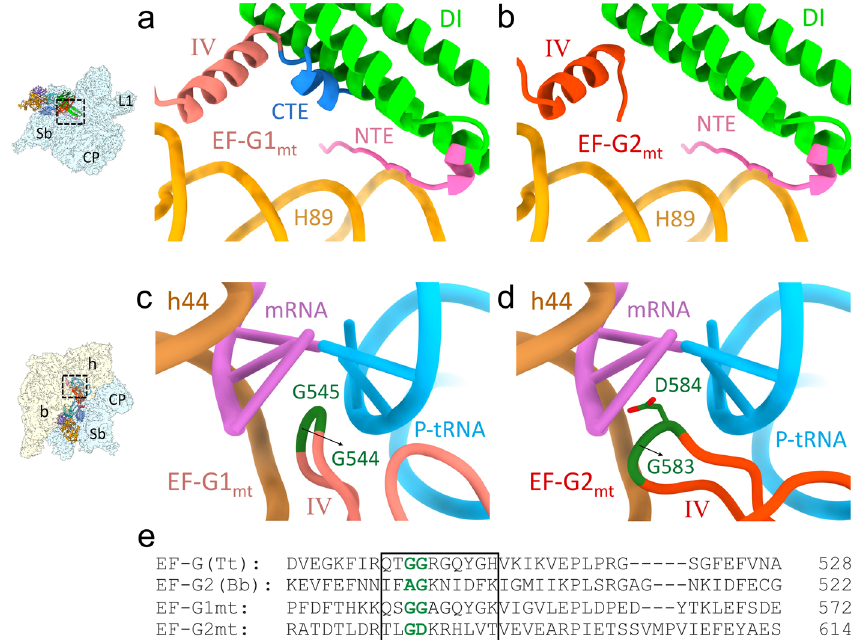
Fig. 6 Structural basis for the exclusive roles of EF-G1 mt in tRNA translocation and EF-G2 mt in mitoribosome recycling. a The presence of a substantially longer C-terminal α -helix (salmon) along with the presence of a unique CTE (blue), which is required for mitochondria tRNA translocation 6 , prevents the simultaneous binding of EF-G1 mt and RRF mt (green) on the mitoribosome due to a major steric clash. Furthermore, any conformational repositioning the C- terminal α -helix of EF-G1 mt will result in direct steric clash with the H89 (orange) of 16S rRNA and the NTE of RRF mt (pink) . b Having a shorter C-terminal α -helix (red) and the absence of CTE allows the simultaneous binding of EF-G2 6 , the presence of mt and RRF mt (green) on the mitoribosome. c In EF-G1 mt two universally conserved glycine residues (dark green) at the tip of domain IV loop1 region (salmon) facilitates its insertion between the mRNA-tRNA duplex at the decoding center (DC) during EF-G1 mt -catalyzed translocation. d In EF-G2 mt, the second glycine of domain IV loop 1 region (red) is substituted by an aspartic acid (dark green) altering its conformation and fl exibility, and thereby making its insertion into the DC during translocation unfavorable. e The boxed aa sequence corresponds to the loop 1 situated at the tip of domain IV, which is conserved between EF-G1 mt and the T. thermophilus EF-G. First of the two universally conserved loop 1 glycine residues (green) is substituted by an alanine in B. burgdorferi EF-G2, while the second one is replaced by an aspartic acid in EF-G2 mt